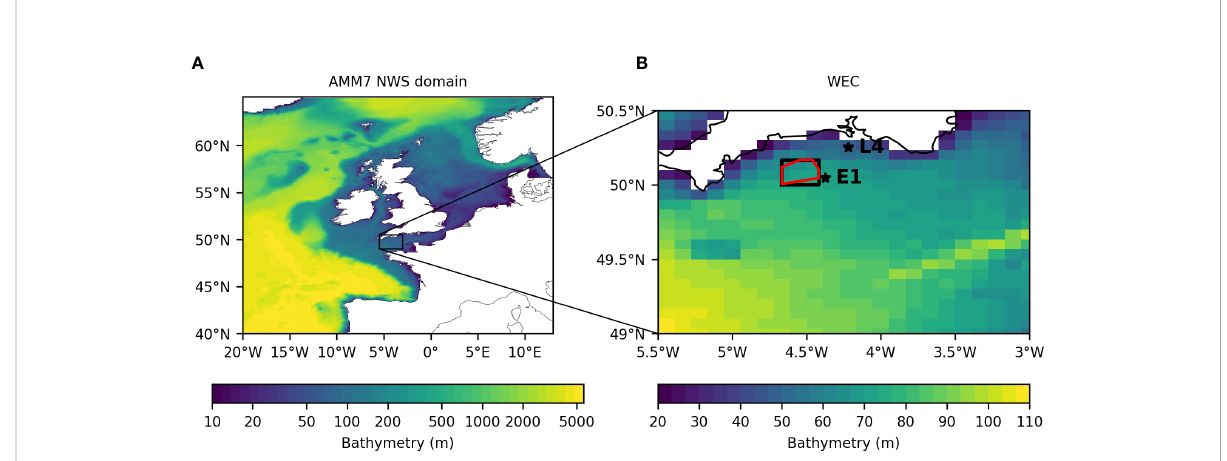
FIGURE 2 (A) AMM7 model domain and (B) close-up on the WEC, colored by the model bathymetry. In (B) , the solid black box shows the area for which the stochastic prediction model produced chl- a forecasts. The red polygon shows the region in which the glider was allowed to travel and in which waypoints could be calculated. The stars show the location of the E1 and L4 time series